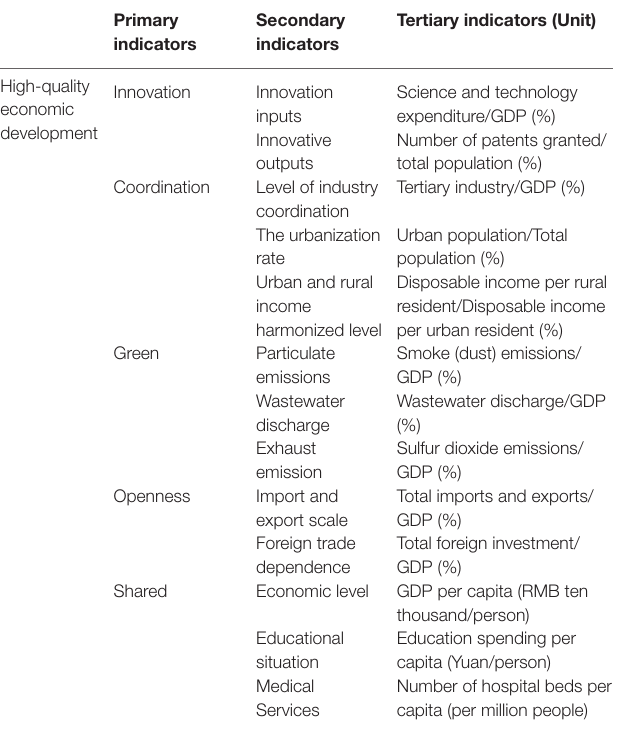
TABLE 2 | System of indicators for quality economic